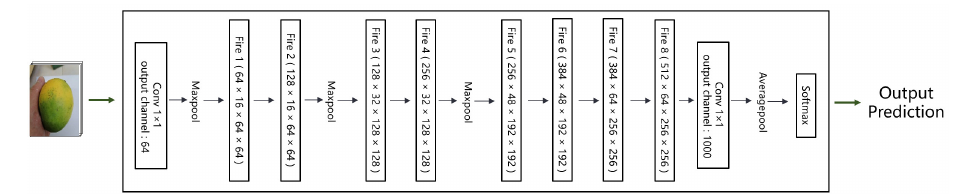
Figure 5. Traditional SqueezeNet network structure.